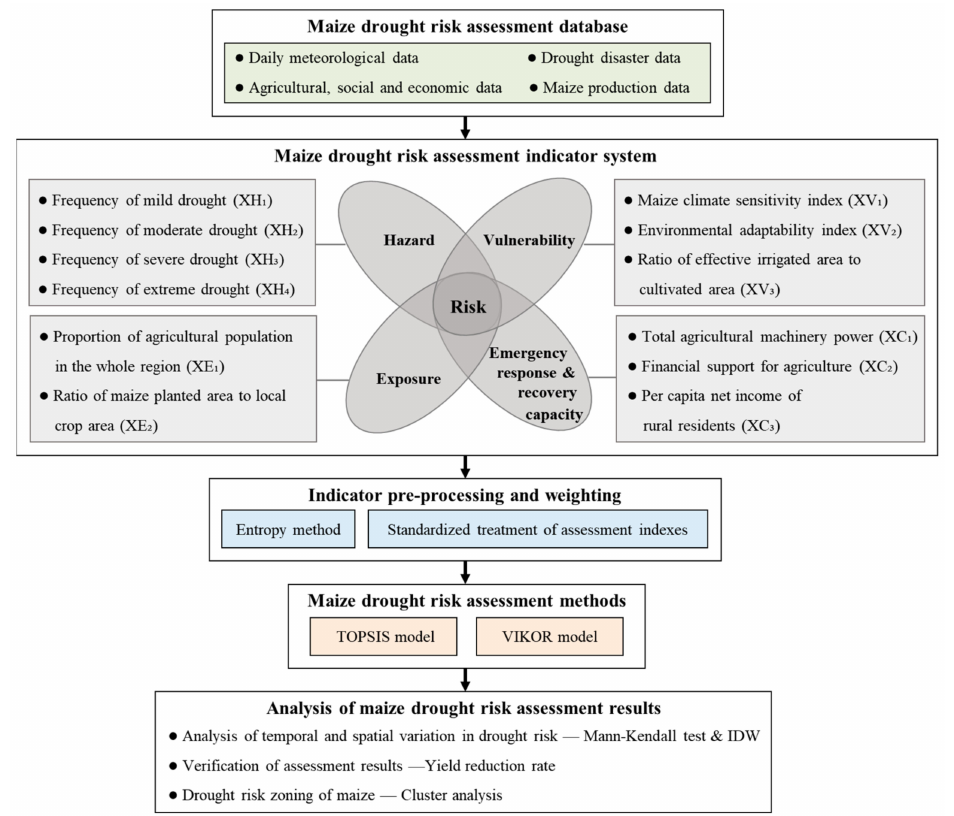
Figure 2. The methodological framework of this